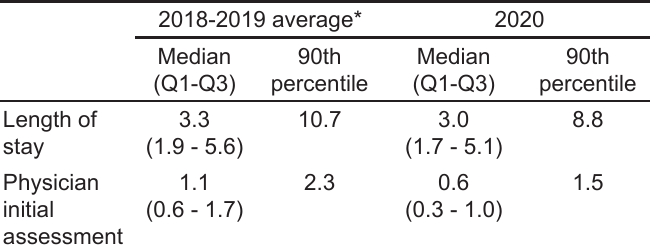
*Average was calculated by dividing the sum of each statistic for 2018 and for 2019 by 2.